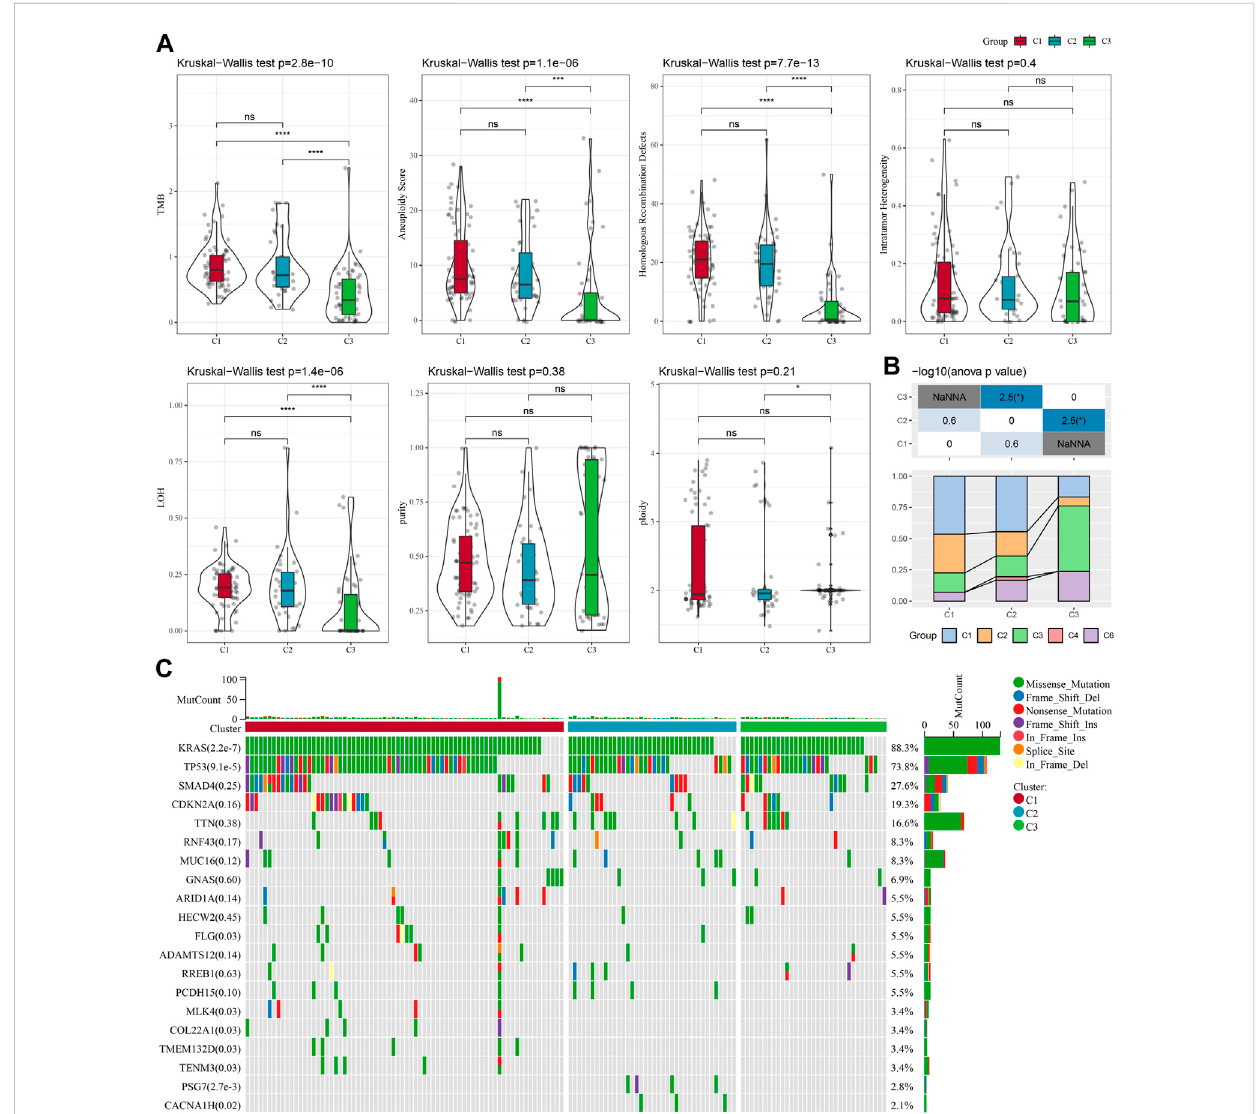
FIGURE 2 In TCGA-PAAD cohort genomic alterations of molecular subtypes. (A) Comparison of Aneuploidy Score, LOH, tumor 25 burden, Intratumor Heterogeneity, ploidy, Homologous Recombination Defects, purity in TCGA-PAAD subtypes; (B) Comparing our molecular subtypes to the other six existing immune molecular subtypes; (C) Chi-square test on the somatic mutations in the three molecular subtypes. * p < 0.05; ** p < 0.01; *** p < 0.001; and **** p <